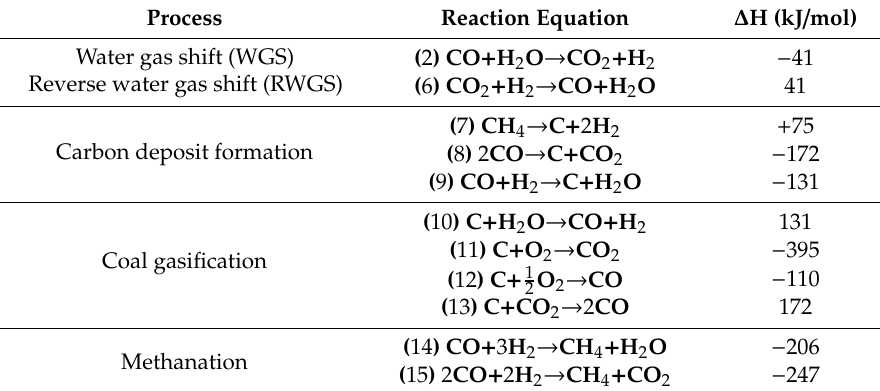
Table 2. Reactions accompanying the methane reforming